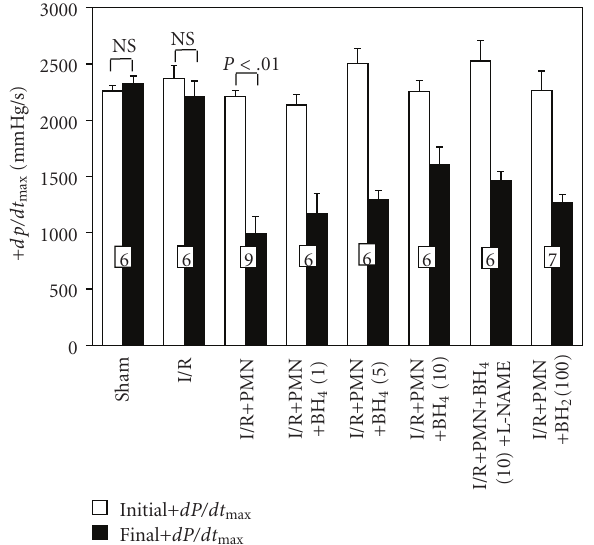
Figure 6: Initial and final + dP/dt max expressed in mmHg/s from di ff erent experimental groups. Hearts were perfused in the presence or absence of PMNs. PMNs induced a significant decrease in + dP/dt max . Neither BH 4 (10 μ M) nor BH 2 (100 μ M) treatment significantly improved + dP/dt max compared to I/R+PMN hearts. All values are expressed as mean ± SEM. Numbers of hearts are at the bottom of the bars. All drugs are in μ M concentrations. (NS, not significant compared to initial LVDP